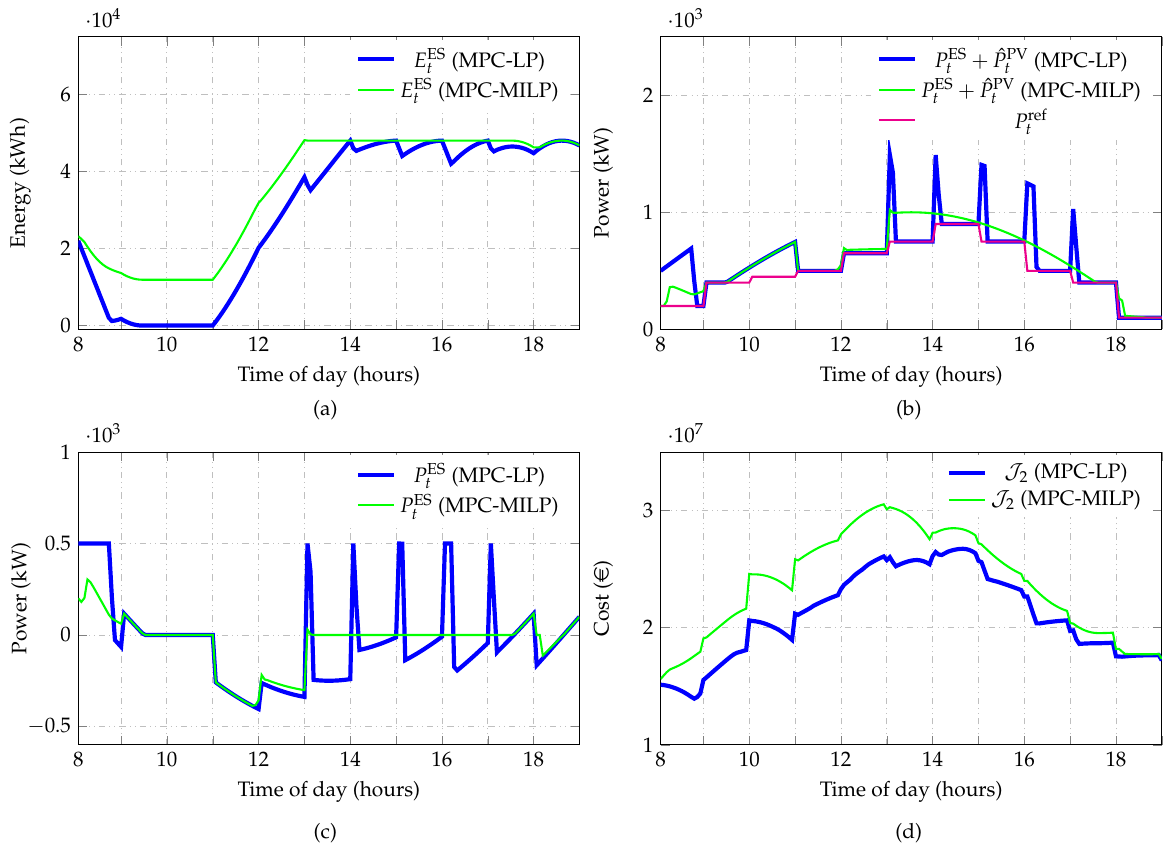
Figure 4. ( a ) Exchange power with the BESS; ( b ) cost of the optimization algorithm; ( c ) energy stored in batteries; and ( d ) power injected into the